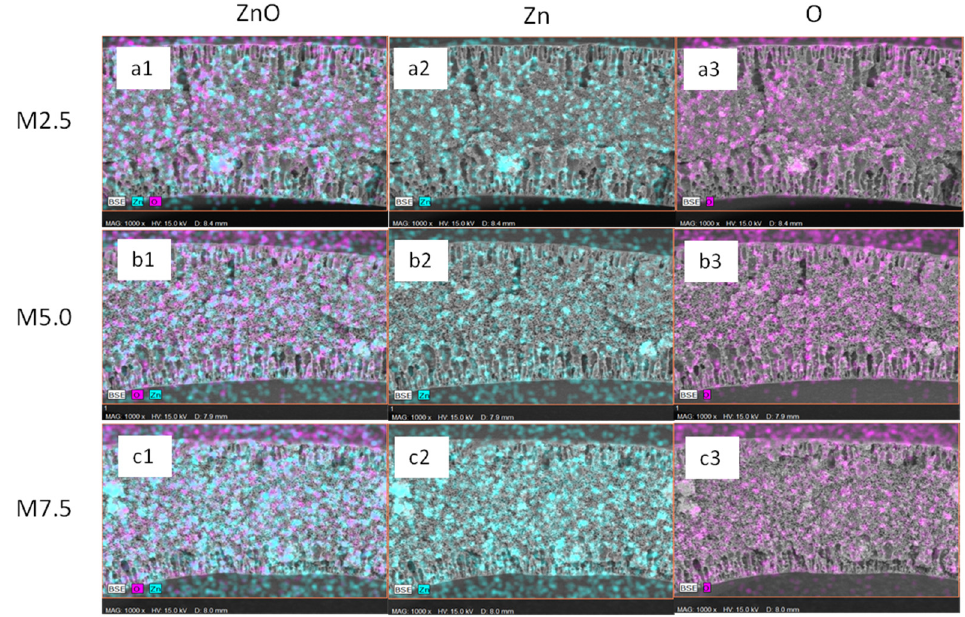
Figure 3. EDX mapping of ( a1 – a3 ) M2.5 ( b1 – b3 ) M5.0 and ( c1-c3 ) M7.5